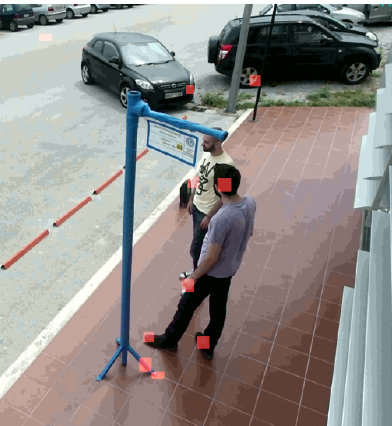
Figure 14. Example of a prediction with a lower regularity threshold.